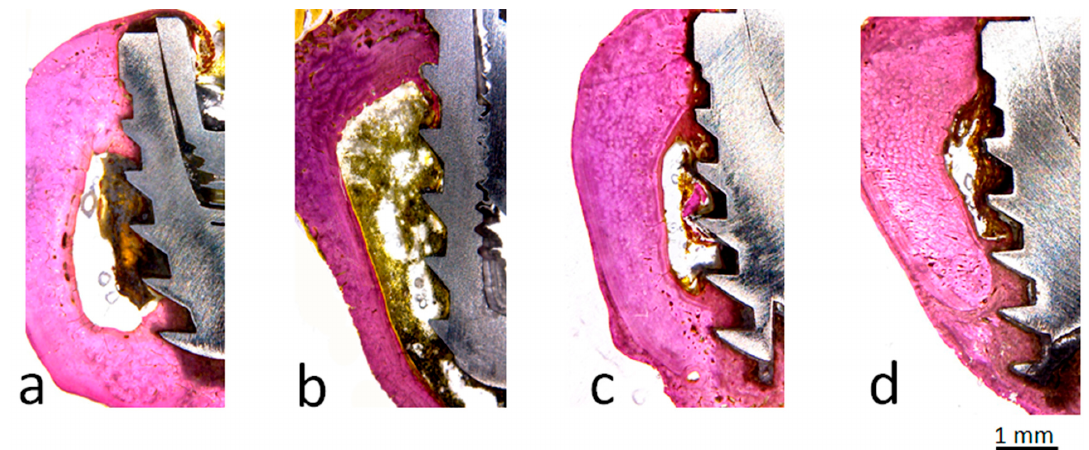
Figure 11. Representative images of the groups 30 days after the implantations. ( a ) G1 group, ( b ) G2 group, ( c ) G3 group, ( d ) G4 group. Images obtained by light microscopy with magnification of 10 × .